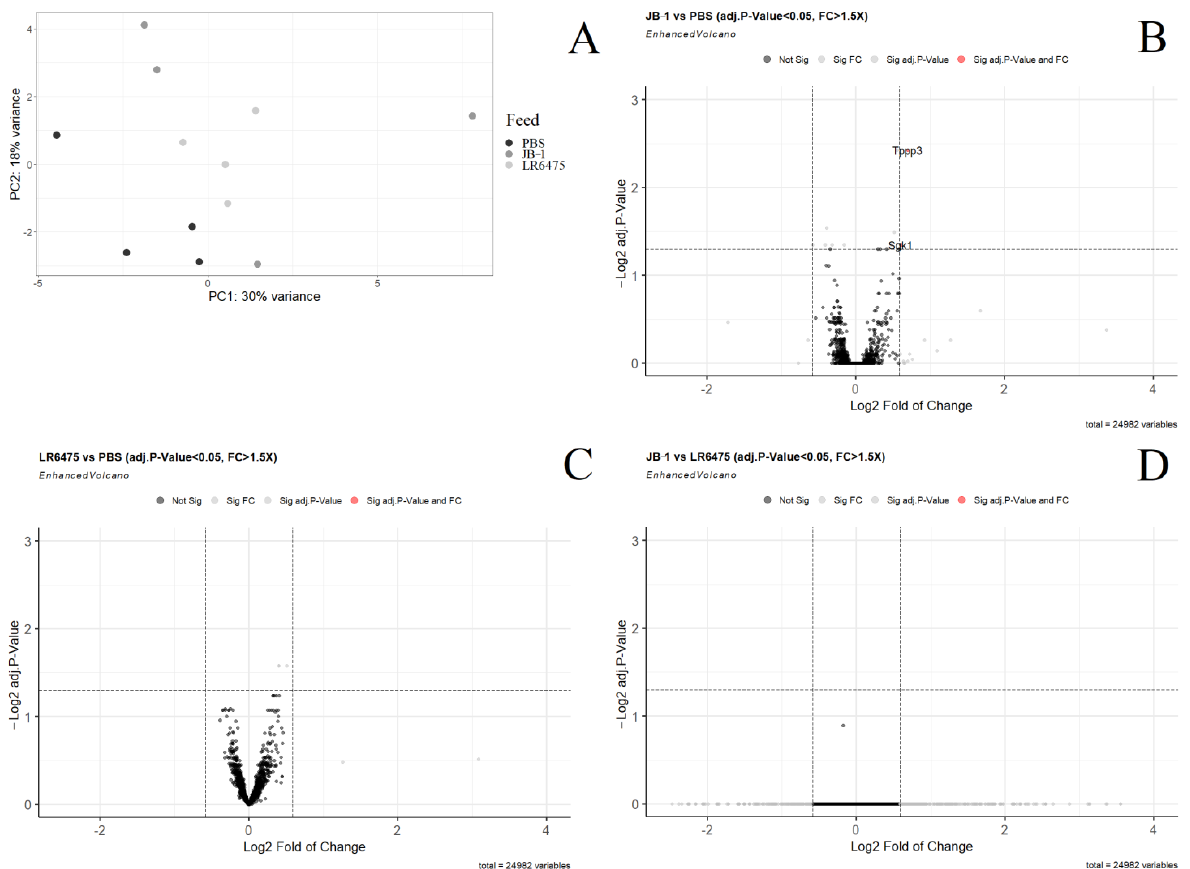
Figure 2. Differential expression analysis of mRNA measured by RNAseq in the hippocampus of mice fed either Lacticaseibacillus rhamnosus JB-1, Limosilactobacillus reuteri 6475, or PBS. ( A ) Principal component analysis of all three treatment groups. ( B ) Volcano plot showing individual differentially expressed genes in a comparison of JB-1 vs. PBS-fed mice. ( C ) Volcano plot showing individual differentially expressed genes in a comparison of LR6475 vs. PBS-fed mice. ( D ) Volcano plot showing individual differentially expressed genes in a comparison of JB-1 vs. LR6475-fed mice. Genes with a positive log fold change are more highly expressed.